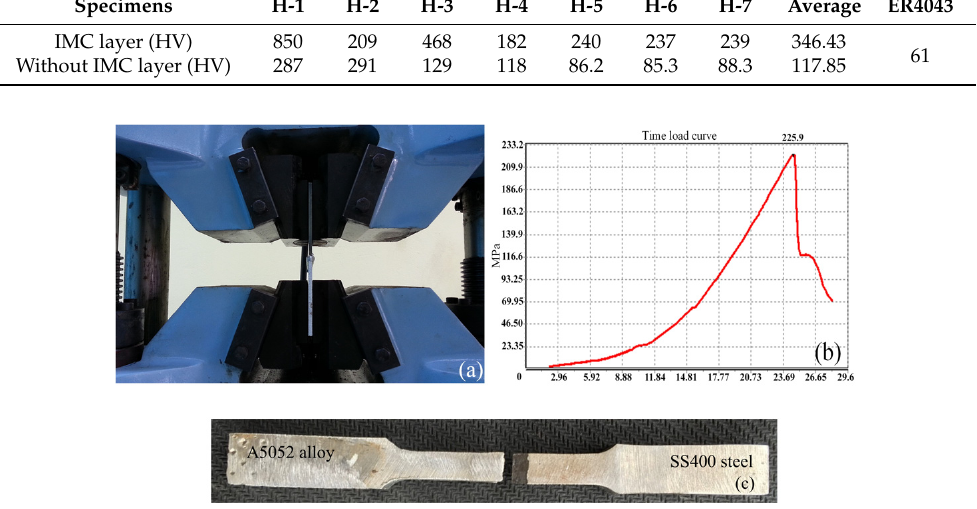
Figure 3. ( a ) Setup of tensile tests of welded samples; ( b ) Deformation load curve results; ( c ) Tensile specimens for metal inert gas (MIG) welding-brazing of A5052 alloy to SS400 steel.